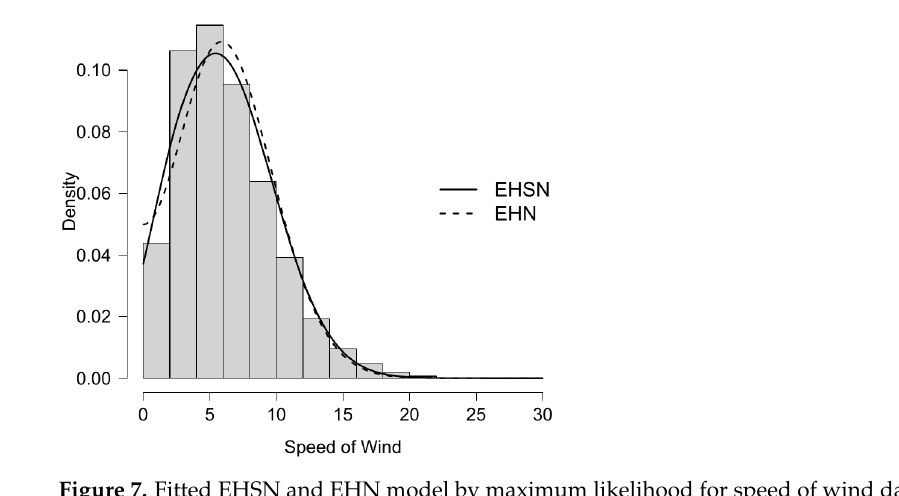
Figure 7. Fitted EHSN and EHN model by maximum likelihood for speed of wind dataset.